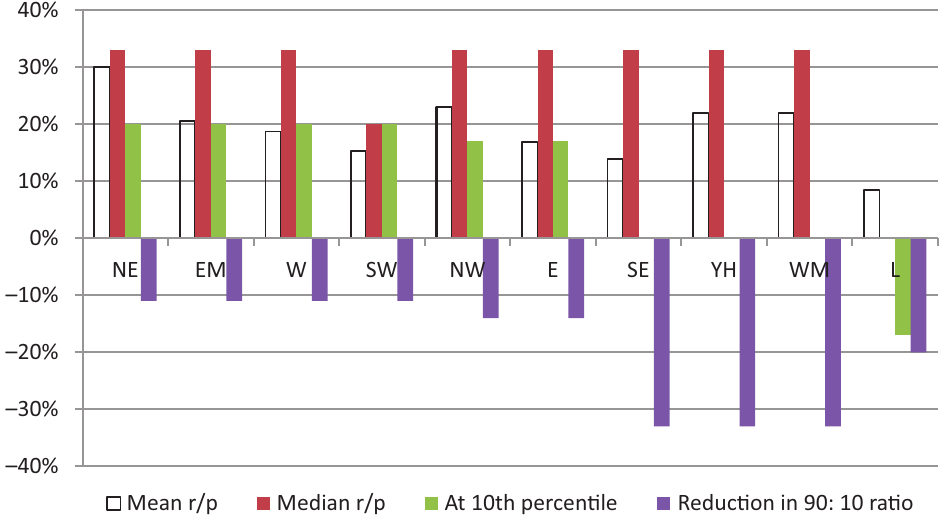
Figure 5. Rates of growth in mean rooms per person, median rooms per person (housing growth), rooms per person at the 10th percentile (inclusivity) and reduction in 90:10 ratio (justness), regions of England and Wales, 1981–2011. Compiled by the author based on data from Casweb for 1981 and Nomisweb for